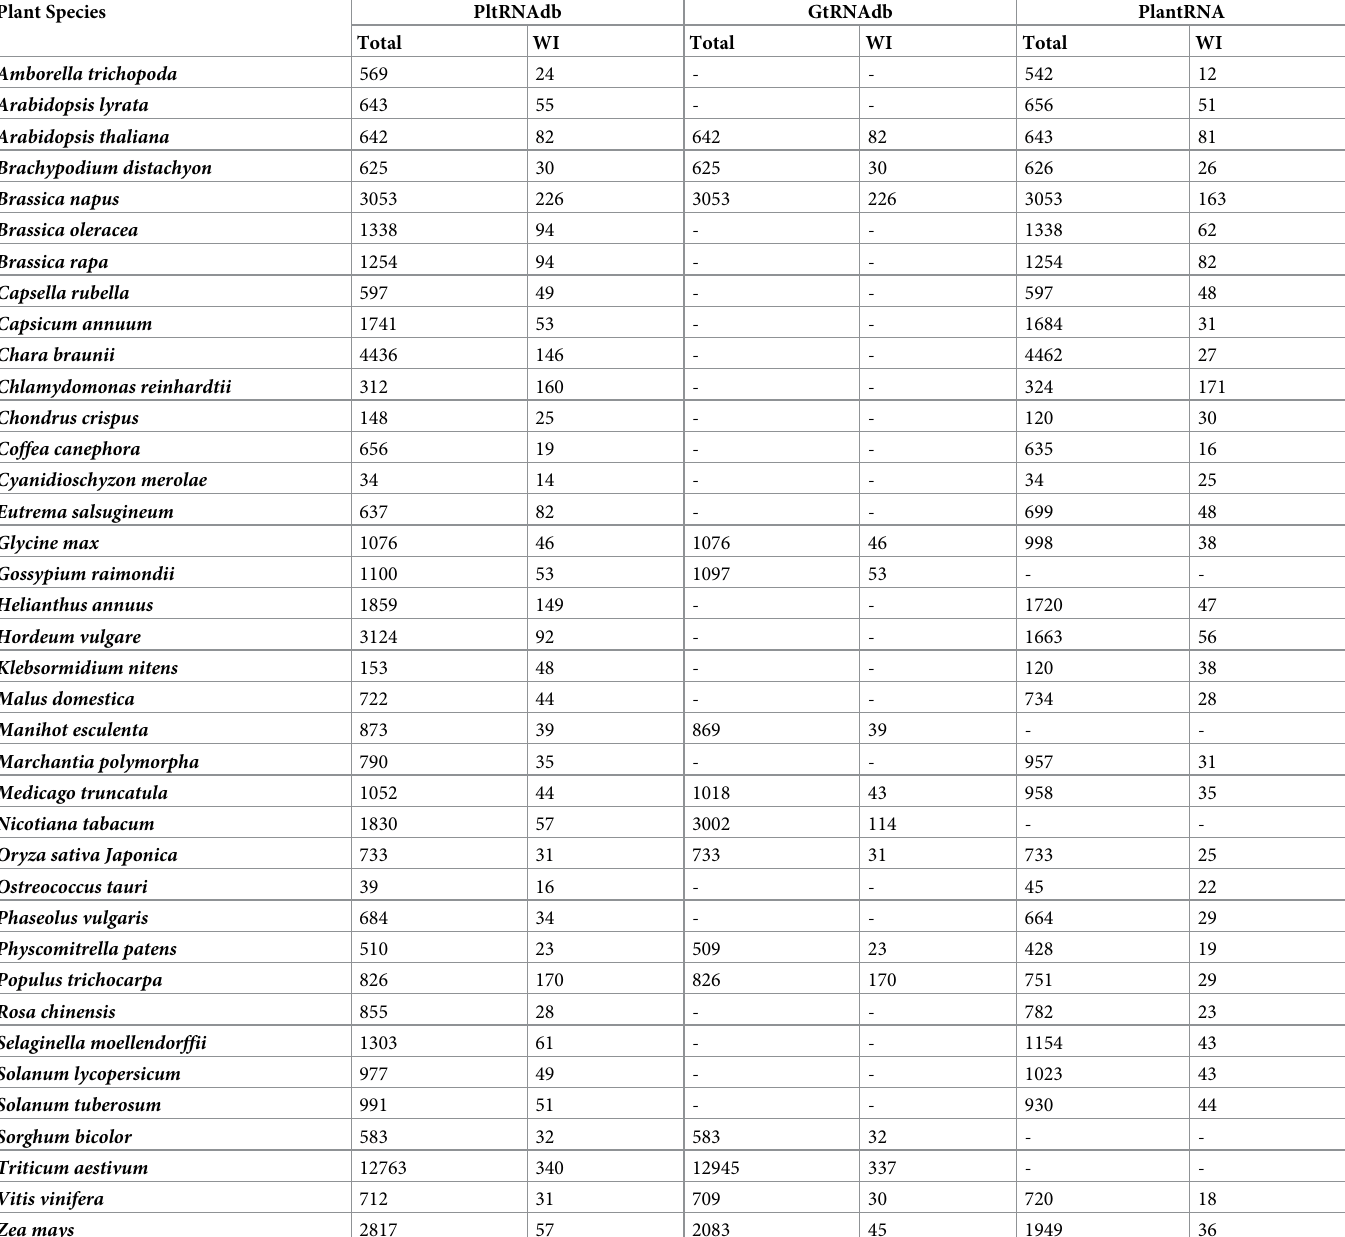
Table 4. Comparison between PltRNAdb (current database), GtRNAdb and PlantRNA databases based on the total number of tRNAs (Total) and the number of tRNAs with introns (WI). Plant